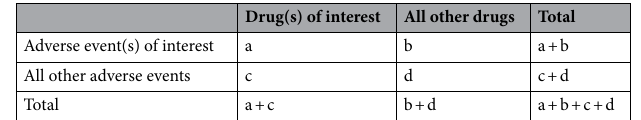
Table 5. 2 × 2 contingency table for disproportionality